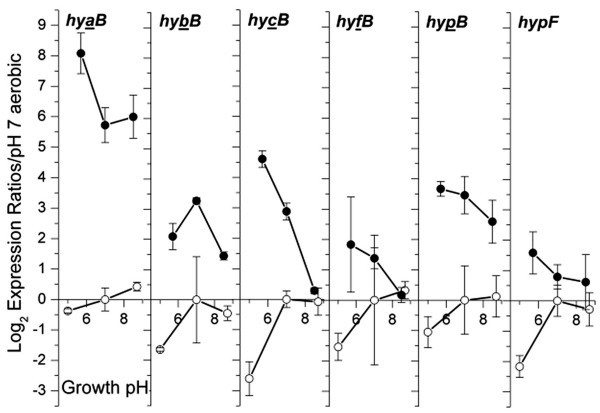
Hydrogenase genes: Real-time PCR expression ratios (aerobic and oxygen-limited). Expression levels were determined as for Fig. 2.